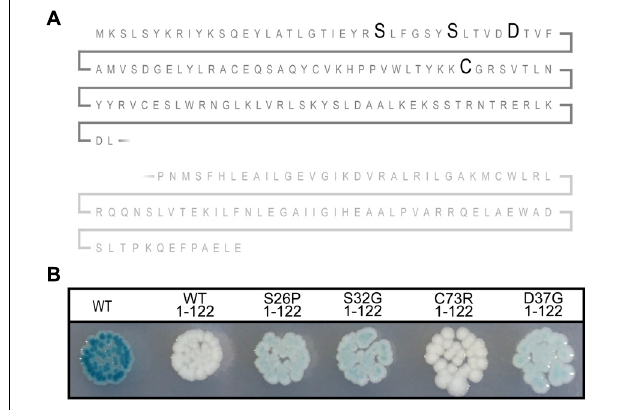
FIGURE 4 | The N-terminal of constitutive Sxy mutants remains active. (A) Schematic of the Sxy N-terminal. The position of mutations S26P, S32G, D37G, and C73R are marked with bold letters. The place of truncation is marked with a broken line. (B) Activities of the truncated Sxy proteins were assessed using a P sxy : lacZ fusion. MG1655 (cid:49) lac pMJ2532 (Jaskolska and Gerdes, 2015) cells expressing wild-type Sxy (WT, pES251) or its truncated derivatives, Sxy 1 - 122 (pES251Sxy 1 - 122 ), SxyS26P 1 - 122 (pES251SxyS26P 1 - 122 ), SxyS32G 1 - 122 (pES251SxyS32G 1 - 122 ), SxyC73R 1 - 122 (pES251SxyC73R 1 - 122 ), or SxyD37G 1 - 122 (pES251SxyD37G 1 - 122 ), were grown on LB agar plates containing X-gal, IPTG, and appropriate